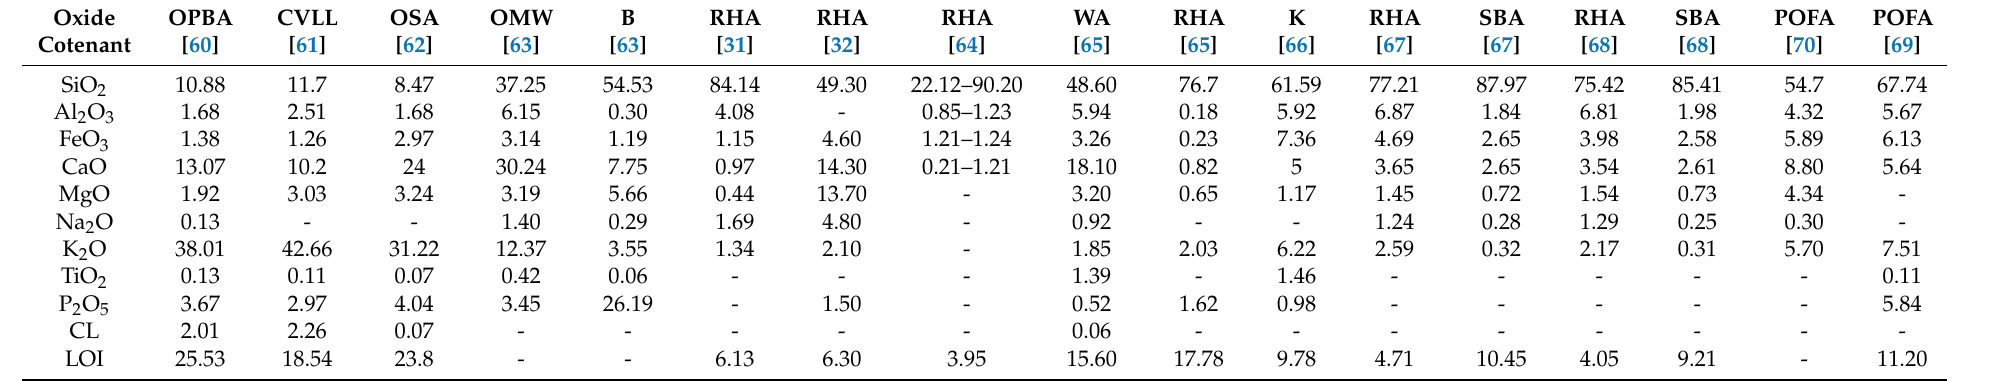
Table 2. The chemical make-up of various lignocellulosic biomass ashes used in the production of fired bricks. Oxide